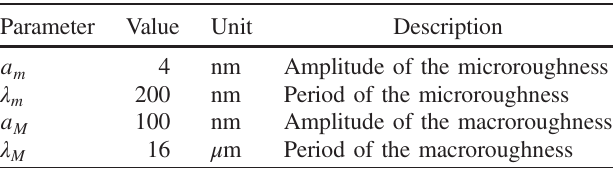
TABLE II. Typical values of the roughness parameters.